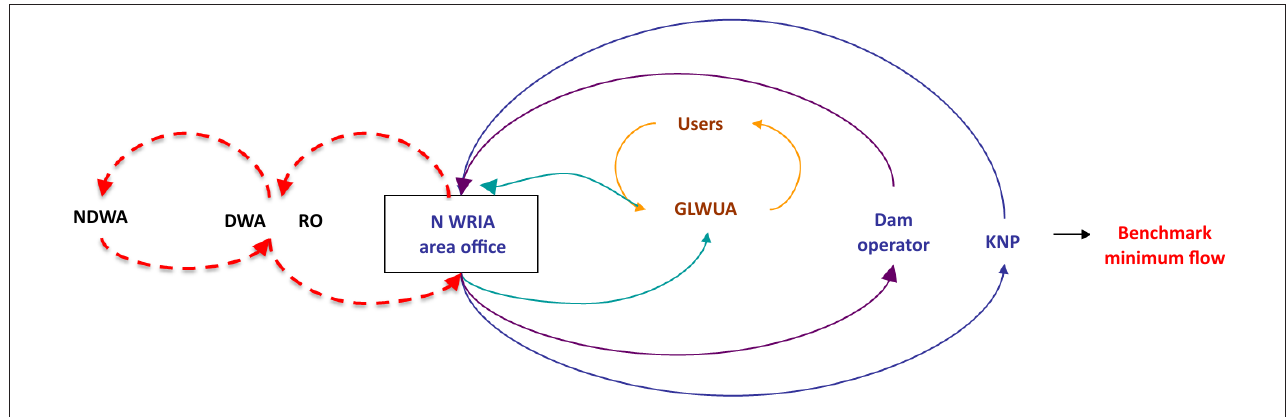
FIGURE 4: Functional feedback loops in the Letaba catchment. Feedback loops are evident when information that arises (discovered or learnt) as part of a management process is passed on to an (appropriate) body who takes (appropriate and effective) action and feeds this back. The self-regulation component is provided for by the water user association regulating its own members through internal agreements and practice. Note the weak linkages to the regional and national Department of Water Affairs.